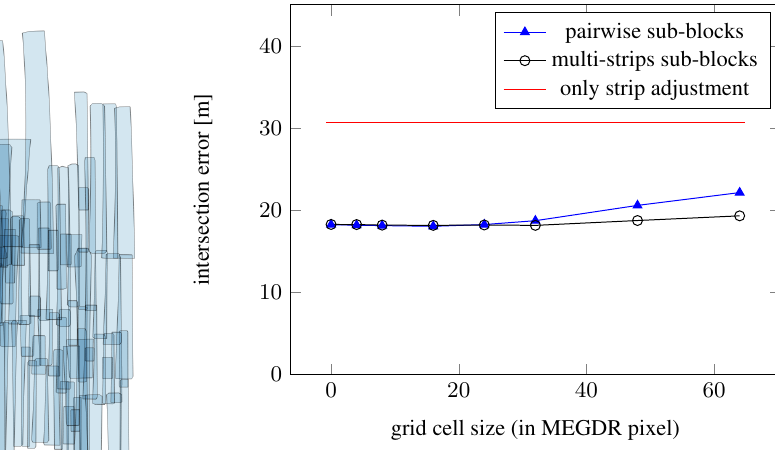
Figure 11: Intersection error of multi-strip tie points